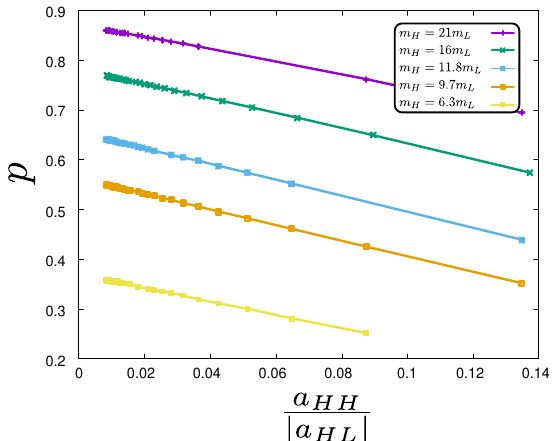
Figure 3. The degree of diabaticity p as a function of the scattering length ratio a HH /∣ a HL ∣ for different